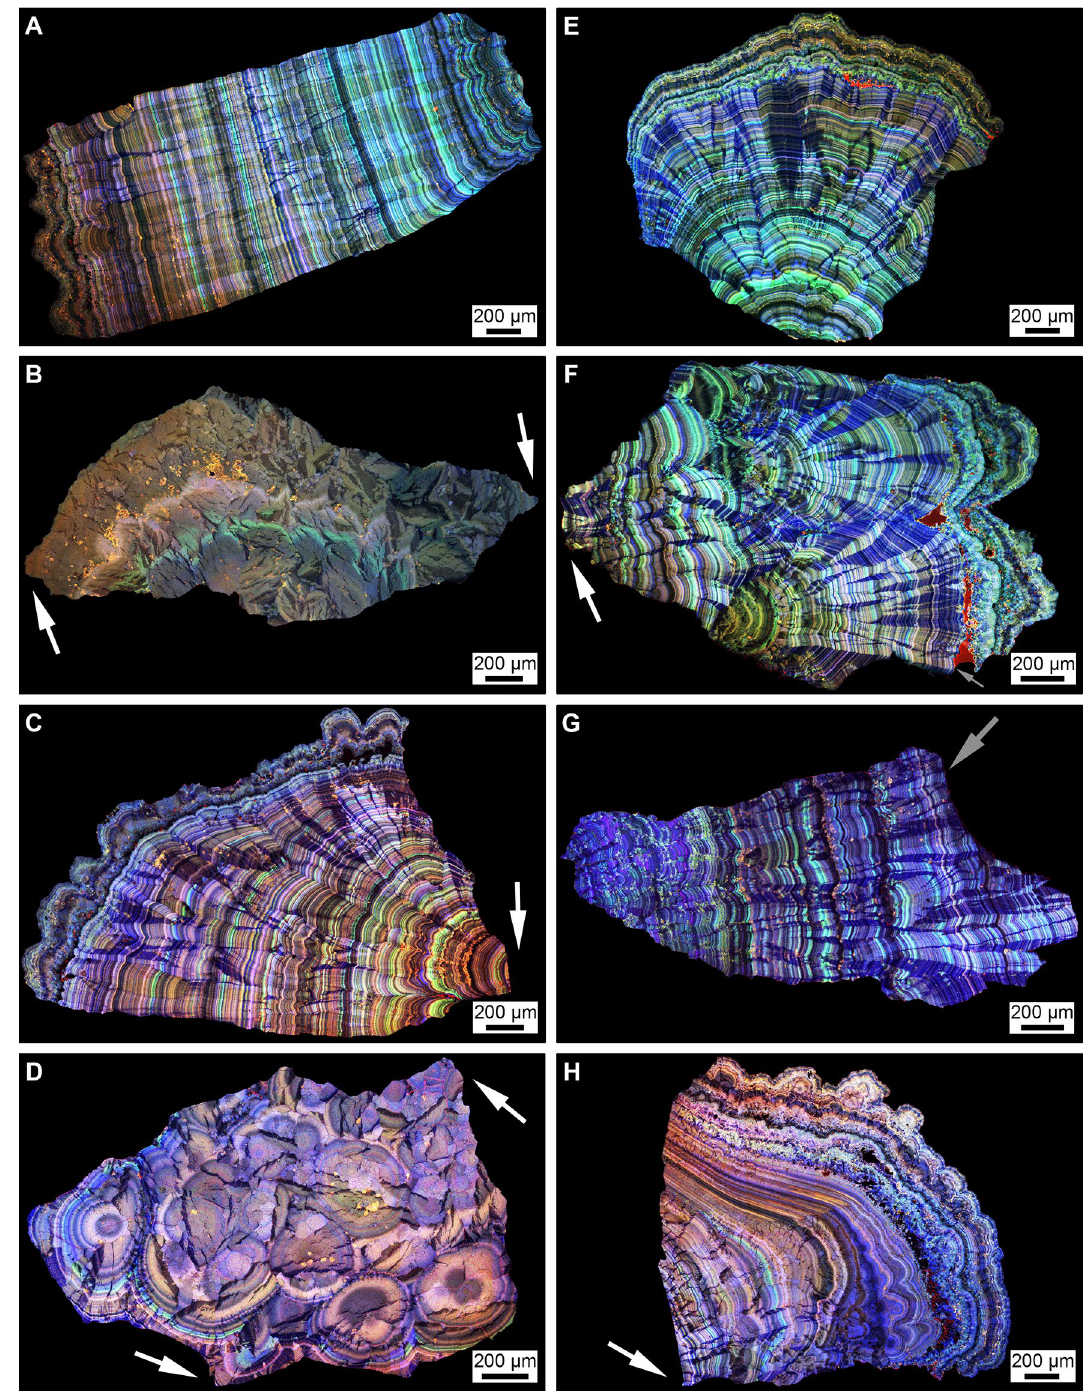
Figure 5. Geometries of SWL-derived particles from groups 106F2-S1 and 106F4-S1 (Fig. 4). These detailed crystal growth structures and fracture patterns, observed in thin section, are analogous to those observed on the polished epoxy plugs (Figs. 3, 6). Red AF emitted from embedding epoxy has been removed from around, but not within each fragment, and replaced with a black background. ( A – H ) CAF images of merged pseudo-colored RGB channels showing SWL fracture geometries that crosscut the original CaOx crystalline architecture. SWL shock fractures propagate at perpendicular and oblique angles with respect to the original crystalline architecture, often converging to form angles of 60°–120° (( B , C , D , F , H ), white arrows). Spalling along concentric crystalline layering is also observed (( F , G ), grey arrows). SWL-derived particle locations shown in Fig. 4 and Supplementary Fig. S5 and corresponding BF and POL figures presented in Supplementary Figs. S6 and